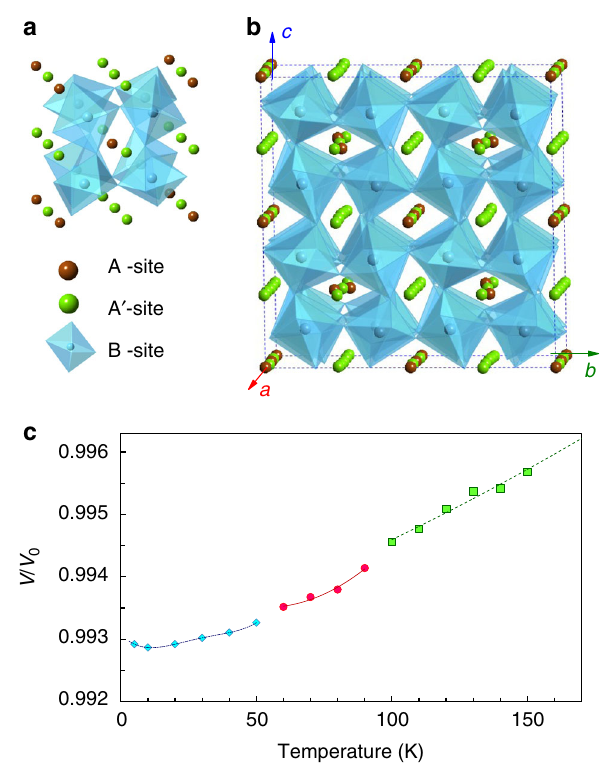
Fig. 1 Crystal structure of the perovskite-type Mn 2 O 3 . a A highly distorted and tilted perovskite unit cell. b The crystal structure of the binary perovskite Mn 2 O 3 determined within the a = 4a p supercell. The oxygen atoms at the corners of the Mn B O 6 octahedra are omitted for clarity. It is a distorted variant of the AA ′ 3 B 4 O 12 perovskite with an in-phase cooperative a + b + c + octahedral tilt. c Relative thermal expansion of the perovskite Mn 2 O 3 ( V 0 is the unit cell volume at ambient conditions). One can see the weak volumetric changes upon the magnetic